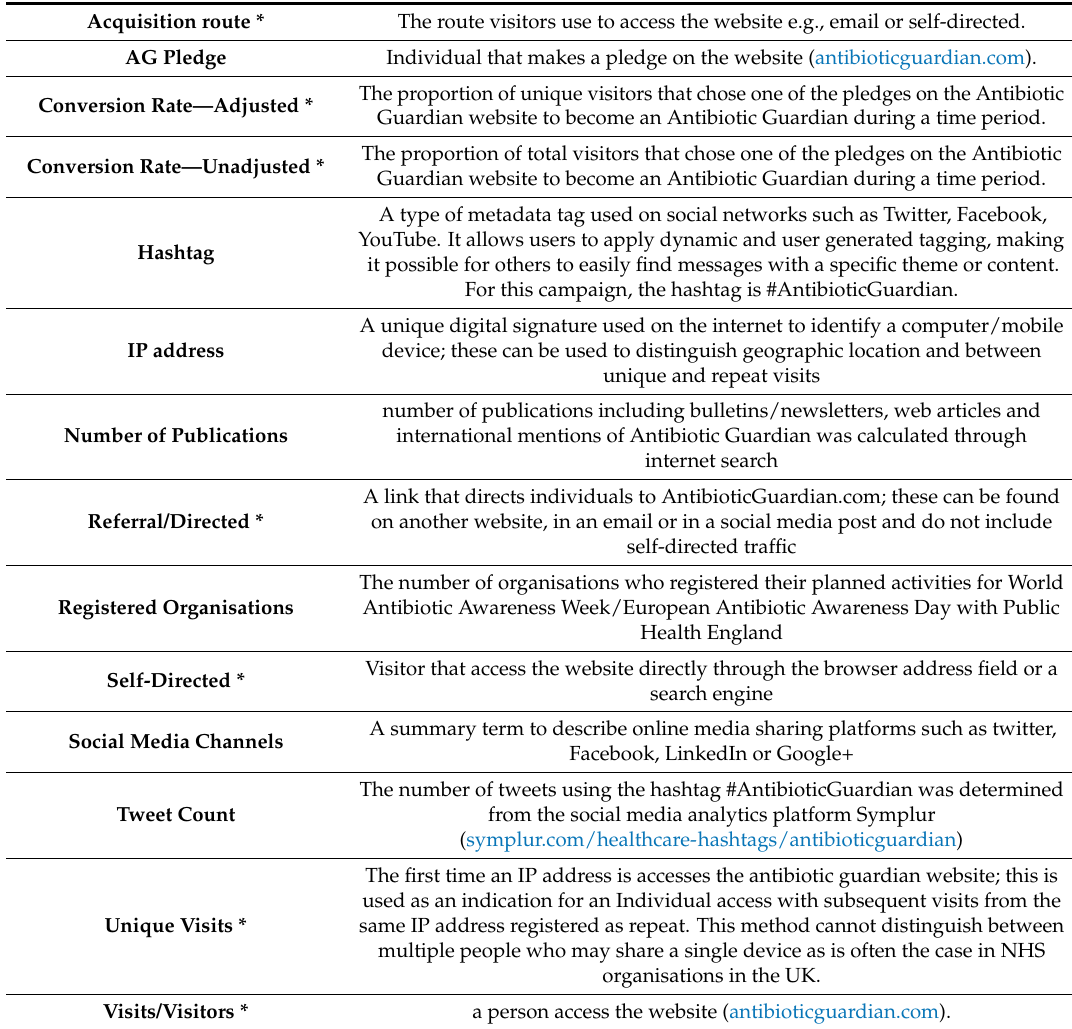
Table 7. Definition of key data